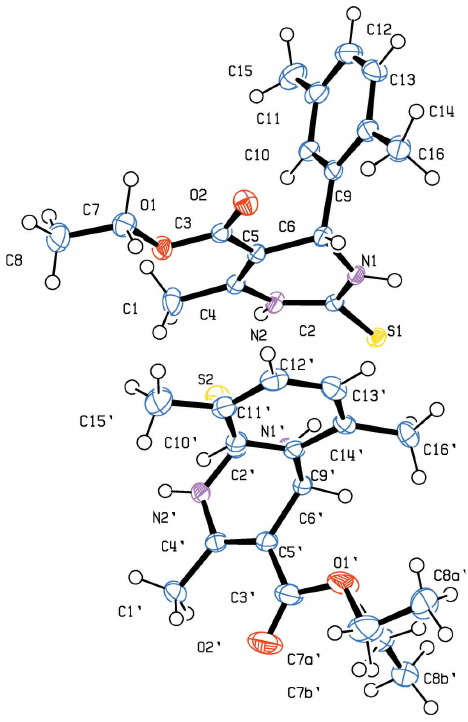
Figure 1 The molecular structure of the title compound, with displacement ellipsoids drawn at the 50% probability level.